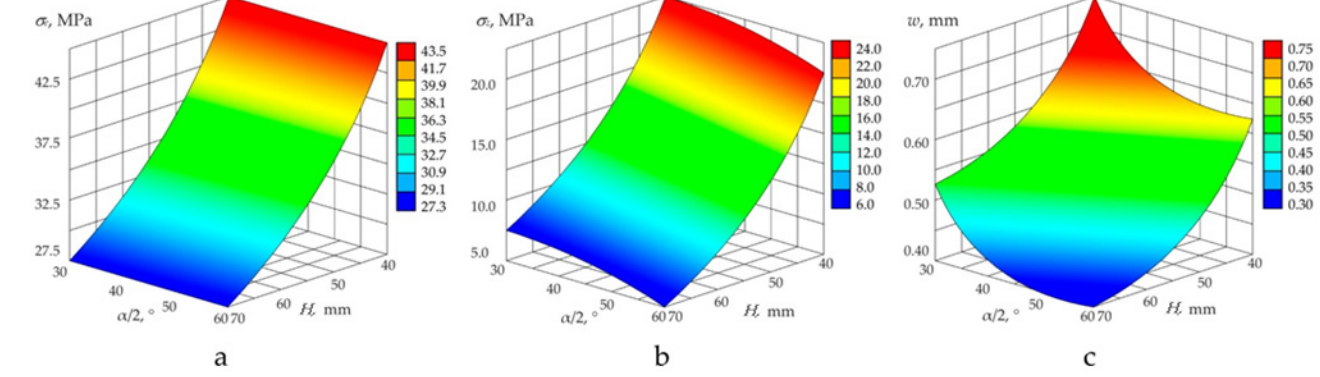
Figure 10. Results of calculations of stress–strain behaviour of the translucent element at the values of tapering angle varying from 60 ◦ to 150 ◦ , thickness from 40 to 70 mm, and constant diameter of the low-pressure surface (115 mm). ( a ) maximum equivalent stress; ( b ) axial stresses; ( c ) low-pressure surface